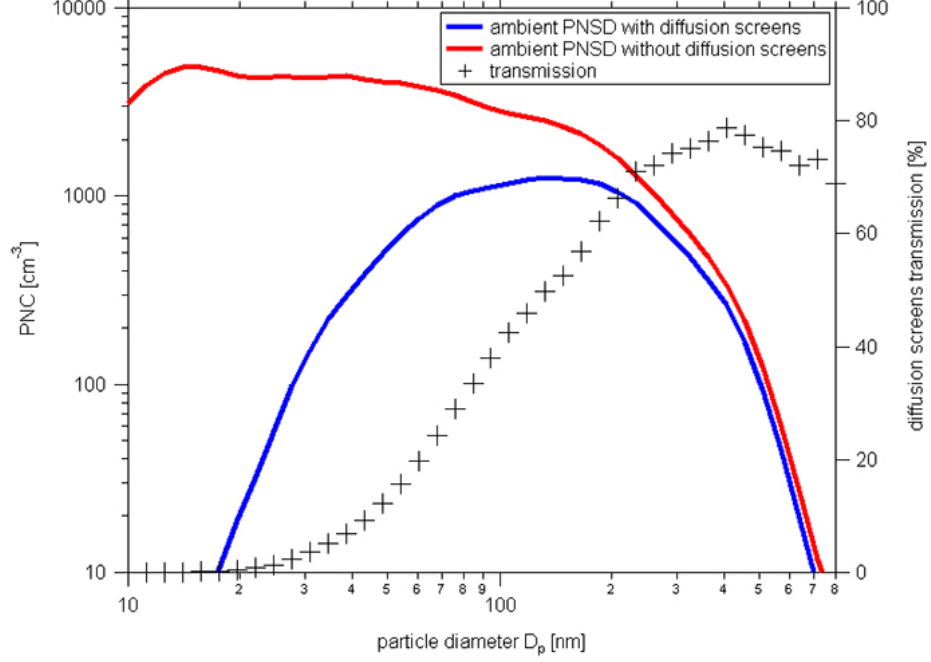
Fig. 5. Exploring the collection efficiency of the diffusion screens: comparison of synchronous measurements of a PNSD with (blue solid line) and without (red solid line) diffusion screens. Black crosses represent the transmission of the diffusion screens.